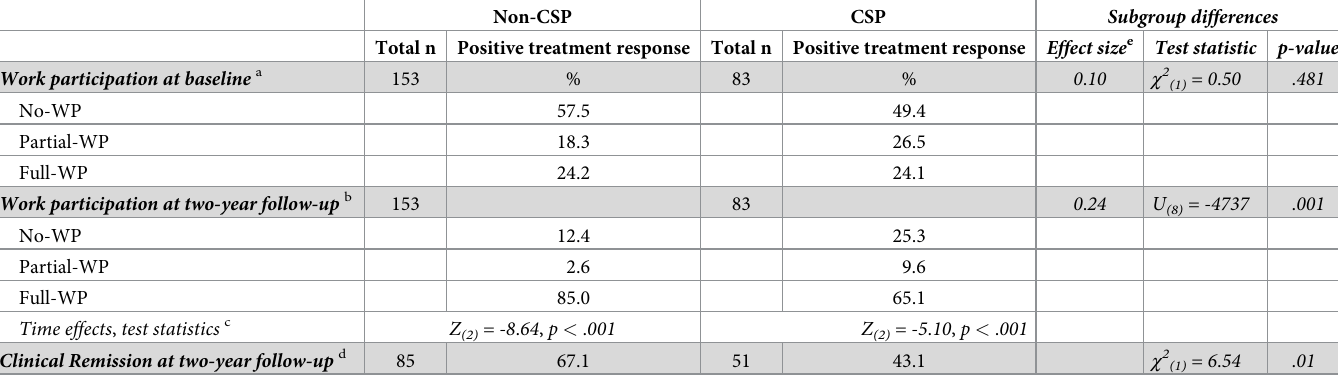
Table 2. Work participation degree at baseline and follow-up and clinical remission rate at follow-up, stratified for the presence of CSP.